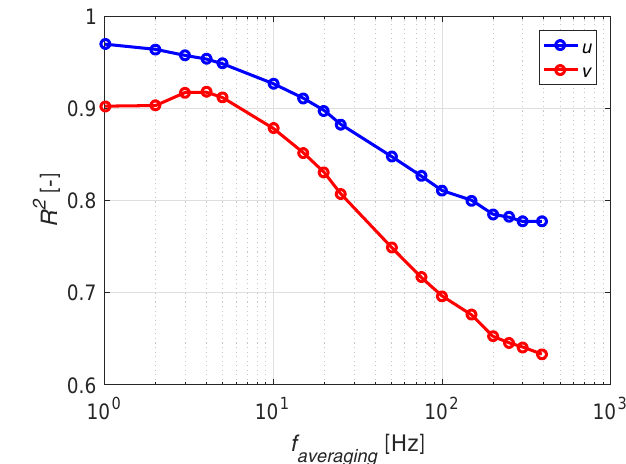
Figure 18. Goodness of fit parameter R 2 for the linear fit between the averaged u and v components of the lidar and the hot wire as a function of the averaging frequency.